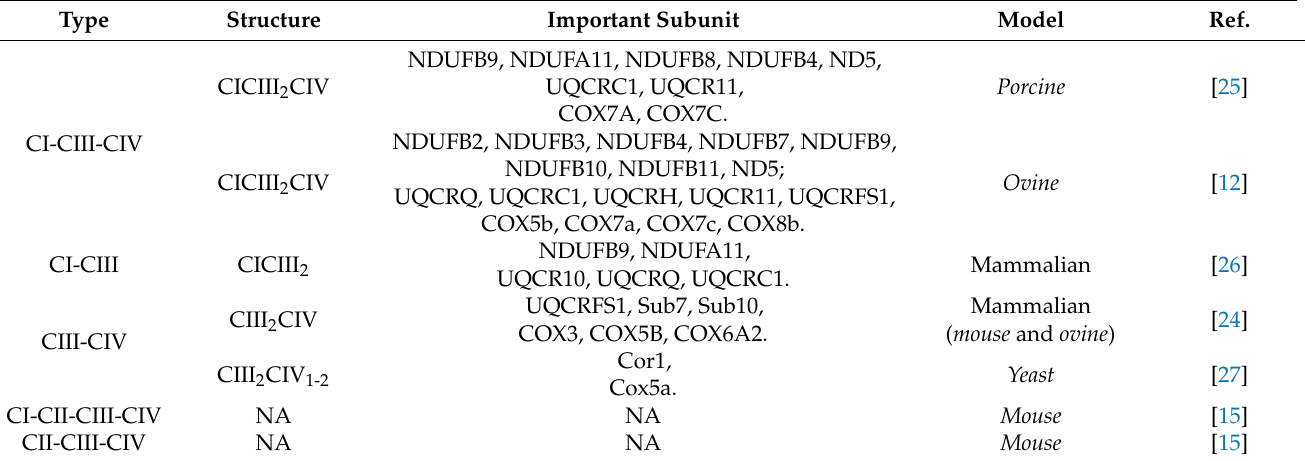
Table 1. Structure and important subunits of various SCs in different